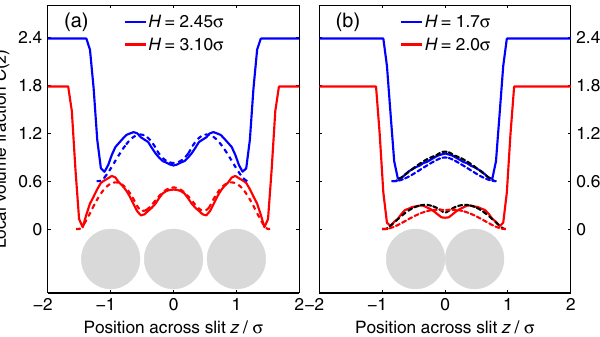
FIG. 2. Density profiles of hard-sphere fluids confined between planar surfaces. Experimental (solid lines) and theoretical (dashed lines) data are presented as a local volume fraction profile C ð z Þ (see text for details). Data are shown at two surface ¼ 0 . 75 σ − 3 , obtained separations H for (a) the dense fluid ( n b from Ref. [25]) and (b) the moderately dense fluid ¼ 0 . 38 σ − 3 ). The theoretical profiles have been obtained ( n b using either hard ( βϵ ¼ 0 ; colored dashed lines) or slightly sticky hard surfaces [ βϵ ¼ 1 . 1 and δ ¼ 0 . 05 σ ; black dashed lines in panel (b)]. The blue profiles are vertically offset by 0.6 units for clarity. The spheres depict the average particle size, while the nearly vertical lines in the experimental data originate from the confining walls.